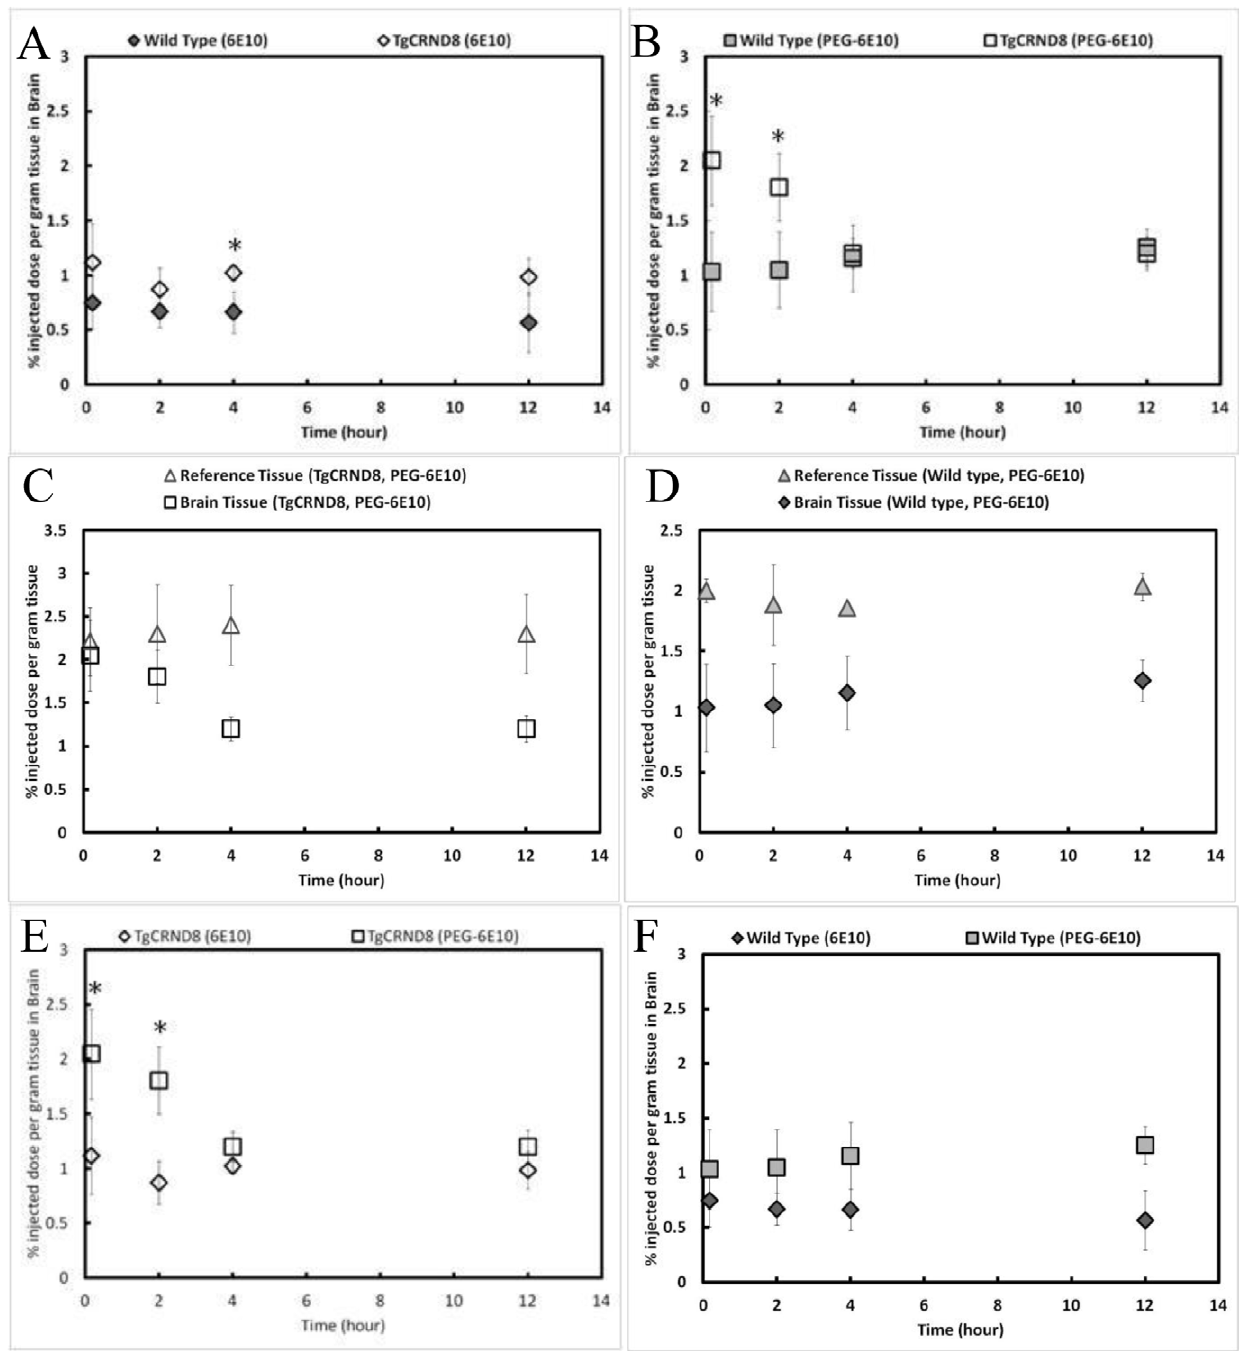
Figure 2. Systemic Delivery of Anti-amyloid- b antibody, 6E10, binds differently in brain tissue of amyloid- b expressing TgCRND8 mice vs. that of native wild type mice. (A) Percentage injected dose per gram of tissue, as quantified by PET, differentiates between TgCRND8 (unfilled shapes) and wild type mice (filled shapes) at 4 h (p=0.041) using 6E10- 64 Cu(diamonds). (B) PEG-modification of 6E10- 64 Cu (squares) increases brain penetration and can distinguish between TgCRND8 and wild type mice at 10 min (p=0.001) and 2 h (p=0.009). (C) PET signal in the brain tissue of TgCRND8 mice decreases over time, whereas the reference tissue (triangles) stays constant, after injection with PEG-modified 6E10. (D) PET signal from the brain and reference tissue in wild type mice stays constant over 12 h. (E) PEG-modified 6E10, vs. 6E10, significantly (p=0.003) increases permeation into brain tissue in TgCRND8 animals at 10 min and 2 h. Post-hoc Holm-Sidak test revealed significant differences at 10 min (p=0.003) and 2 h (p=0.002). (F) PEG-modified 6E10 similarly increases permeation of antibody into brain tissue in wild type controls (p , 0.001). Post-hoc Holm-Sidak test revealed no significant differences at any time point. For all graphs, n=3, mean 6 standard deviation plotted.